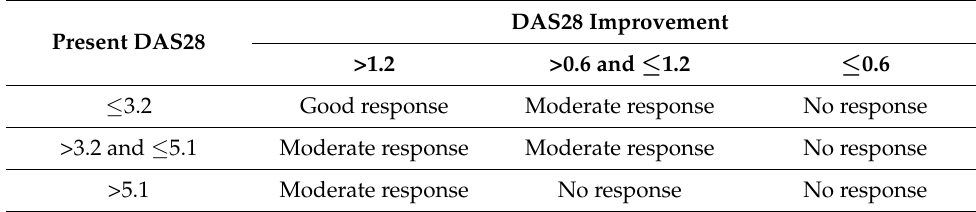
Table 1. EULAR therapy response criteria using